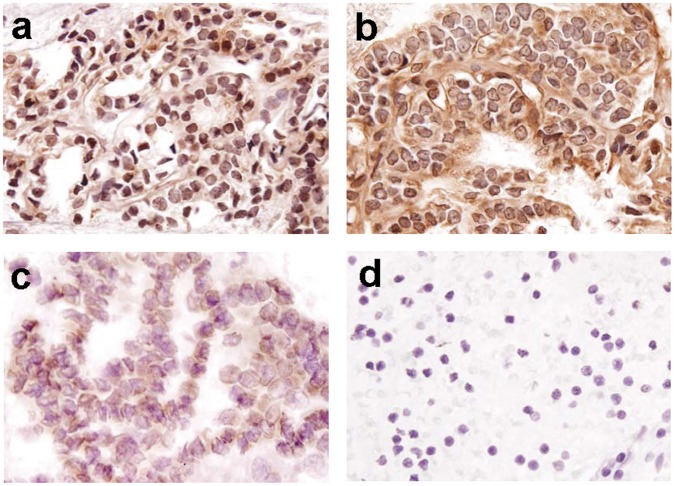
Biotinidase expression in thyroid FNA samples.FNA specimens from benign (Panel a), non-aggressive papillary thyroid cancer (Panel b), and aggressive papillary thyroid cancer (Panel c) cases were immunostained with 1∶100 α-biotinidase K-17 rabbit polyclonal antibody. FNA specimen used as a negative control shows no immunoreactivity in cells (Panel d). Photomicrographs show a pronounced decrease in nuclear biotinidase expression in more aggressive thyroid cancer cases and are presented at 400× original magnification.